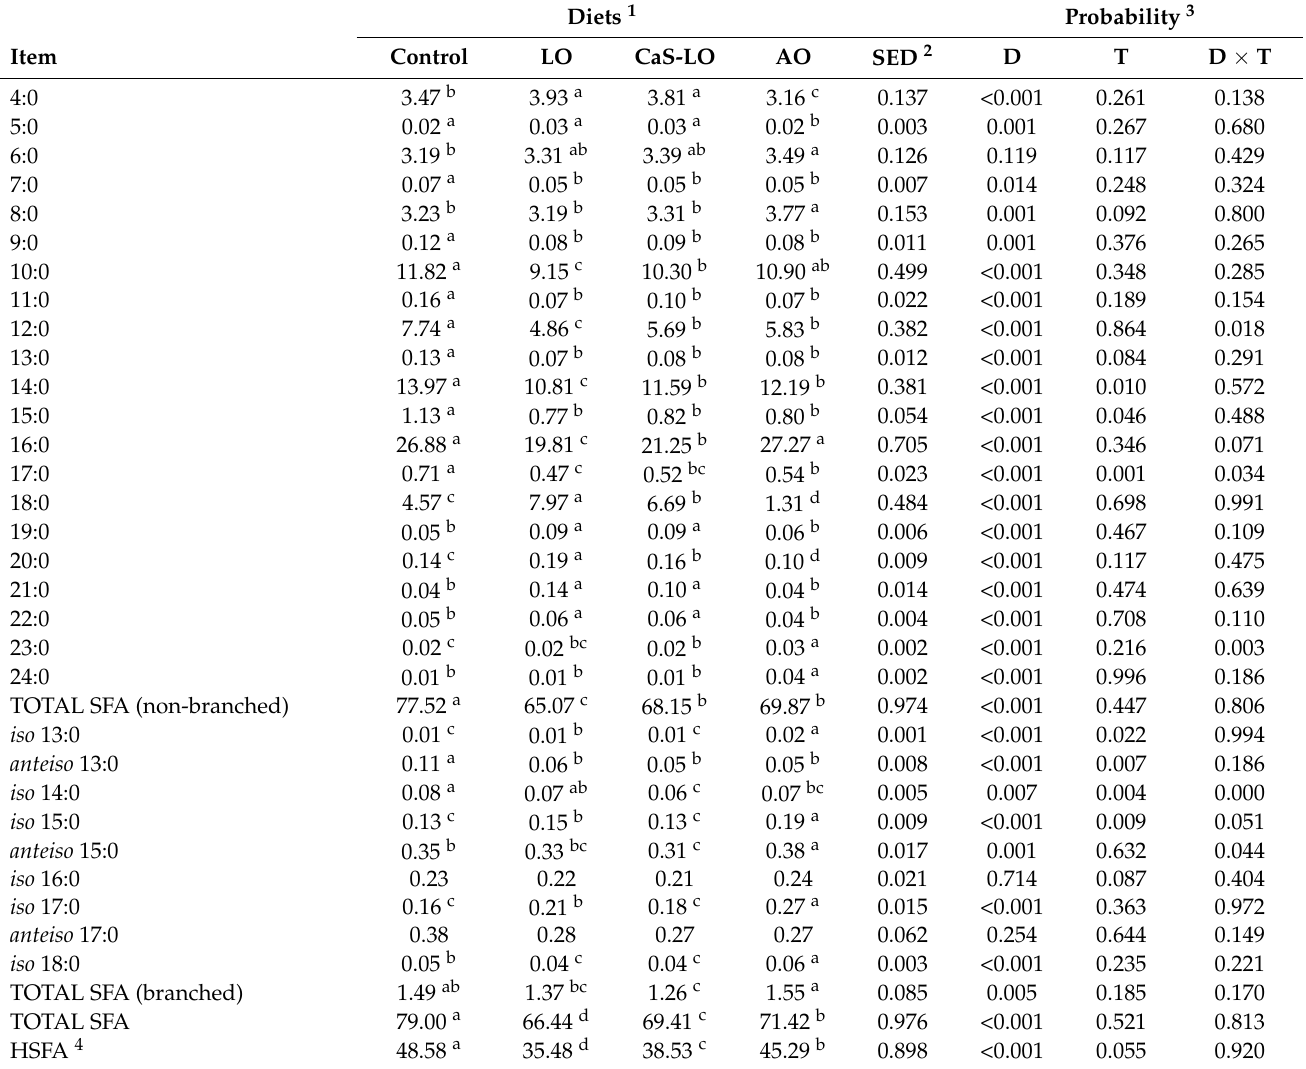
Table 3. Saturated fatty acid (SFA) profile (g/100 g of total fatty acid methyl esters) of milk fat from ewes fed with 2.3% of different lipid supplements. Diets